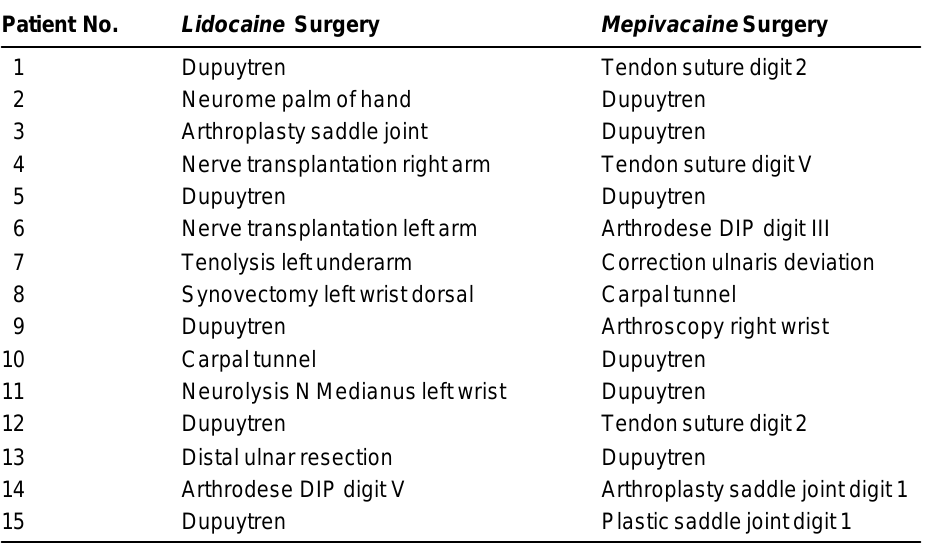
Type of Surgery in Both Groups of